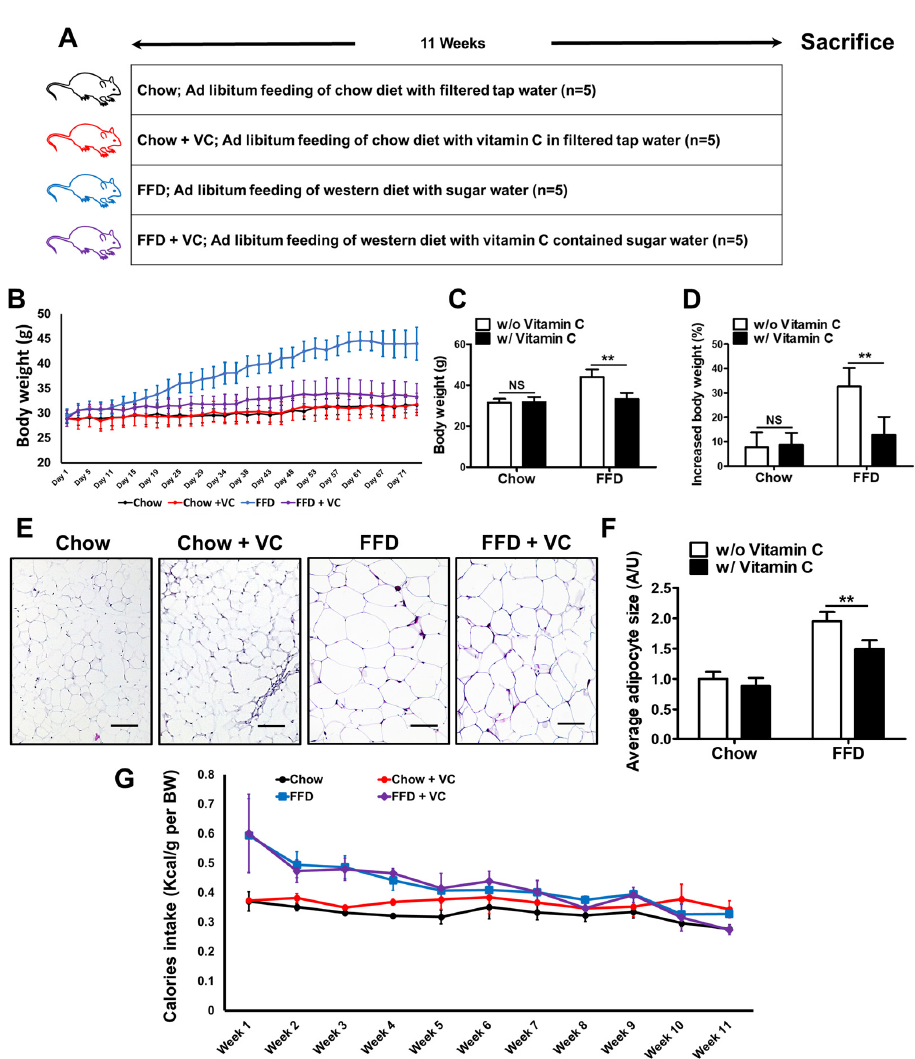
Figure 1. Comparison of body weight and calories intake between each mouse group. ( A ) Schematic diagram of the experimental protocol used to assess the effect of mega-dose vitamin C treatment on NAFLD ( B ) The body weight data of whole mice groups for entire experimental periods. ( C ) The body weight of final day; and ( D ) The increased body weight ratio (%) ( E ) Representative images of hematoxylin and eosin (H&E) staining; and ( F ) relative size of adipocytes. ( G ) The calories intake per body weight levels in whole mice groups for entire experimental periods. Data are expressed as means ± SD per group ( A – D , F ). n = 5 mice in each group ( A – F ). ns = not significant ( p >0.05), ** p < 0.01. Scale bars = 100 um ( E ). Original magnification, 200× ( E ). 3.2. Mega-Dose Vitamin C Treatments Reduced Hepatic Triglyceride Accumulation in the Fast-Food-Diet Fed Mice In the gross examination, the livers of the Chow and Chow + VC groups exhibited a shiny and reddish surface color, while the livers of FFD group showed a larger size, pale surface color, and multifocal white spots suggesting severe fat accumulation in the liver. Interestingly, the livers from FFD + VC group exhibited smaller size, reddish surface color and smoother appearance compared with those in the FFD group despite the FFD-diet ingestion (Figure 2A). Additionally, the FFD + VC mouse group showed decreased liver weights compared to the FFD mouse group (Figure 2B,C). In contrast, both Chow and Chow + VC groups exhibited similar gross appearance and liver weights (Figure 2A–C).